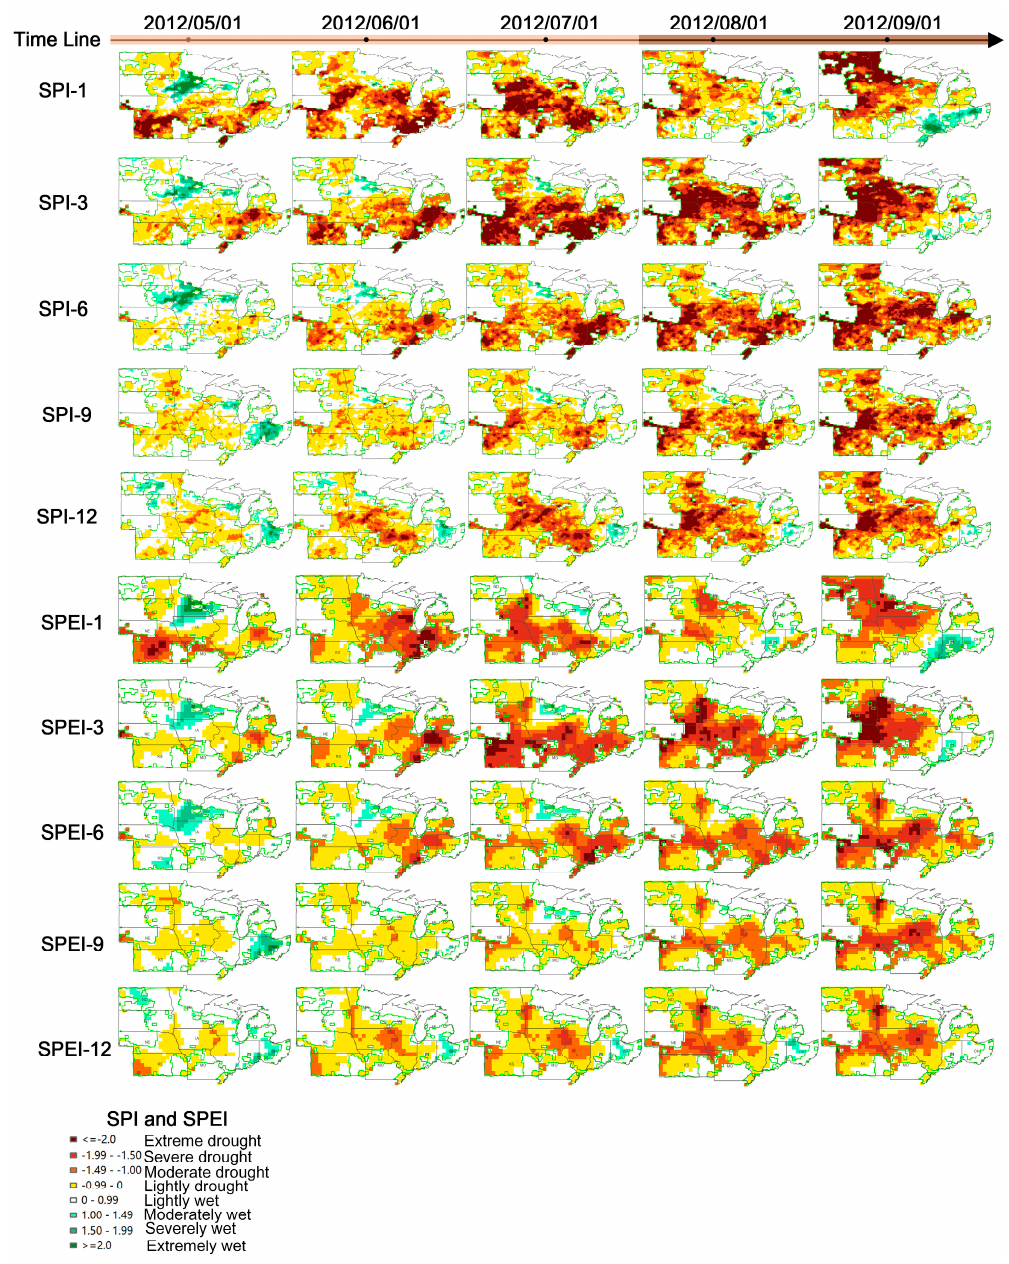
Figure 4. Spatio-temporal distribution of 2012 Midwest drought using SPI and SPEI from the time scale of 1 month to 12